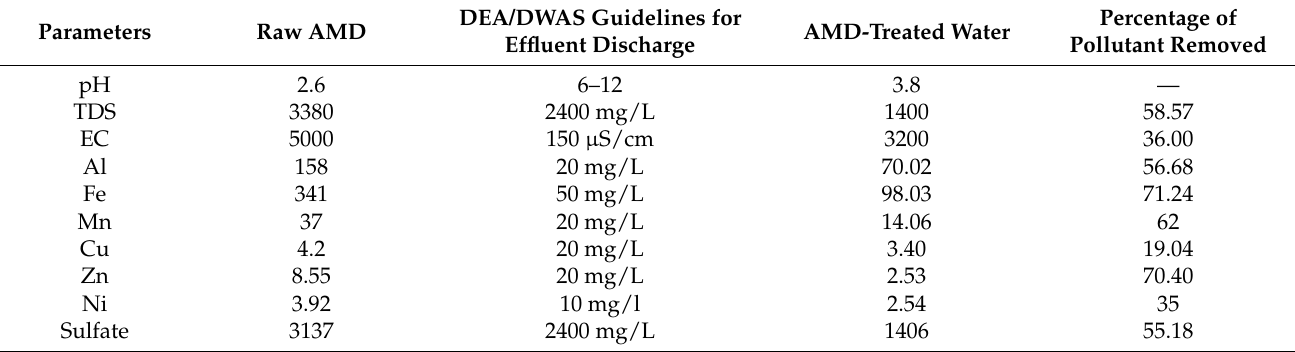
Table 6. Concentrations of chemical species for untreated and AMD-treated wetland with SSVF-CW (all units in mg/L except pH and